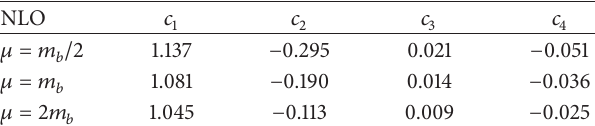
Table 1: The Wilson coefficients 𝑐 𝑖 in the NDR scheme at three different choices of the renormalization scale 𝜇 [18].